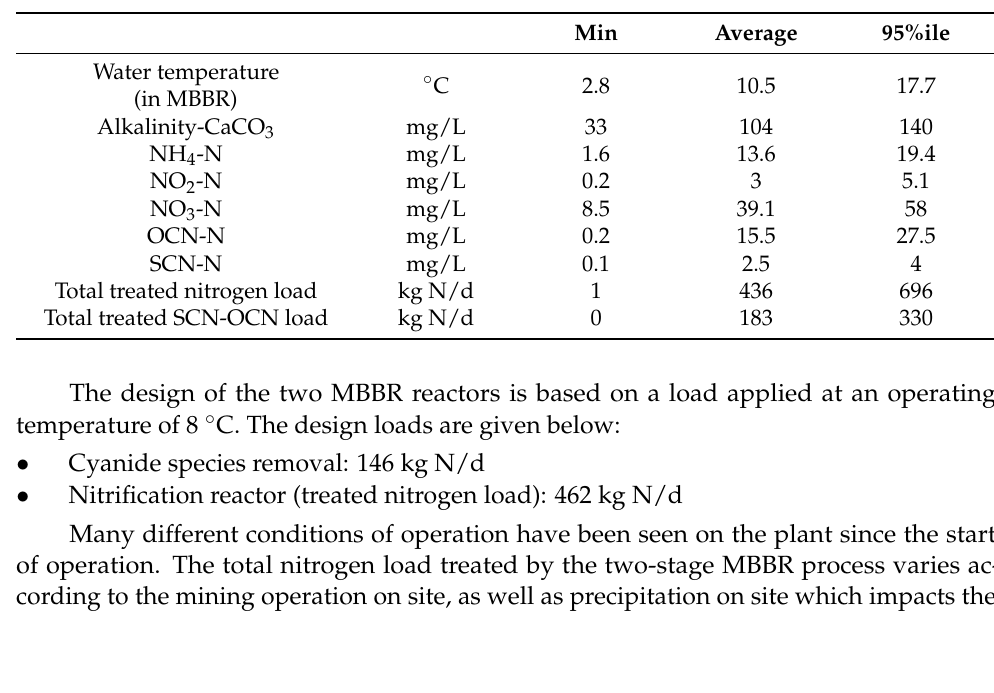
Table 5. Characteristics of full-scale plant influent